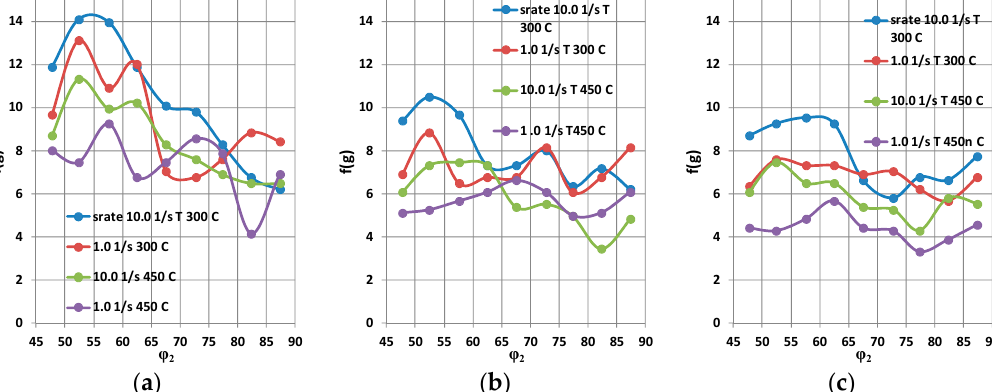
Figure 10. Model-based calculation of texture components’ re-distribution with increasing deformation strengthening: ( a ) Aluminum Al 99,5 (AA1050); ( b ) Al-Mg1; ( c ) Al-Mg4.